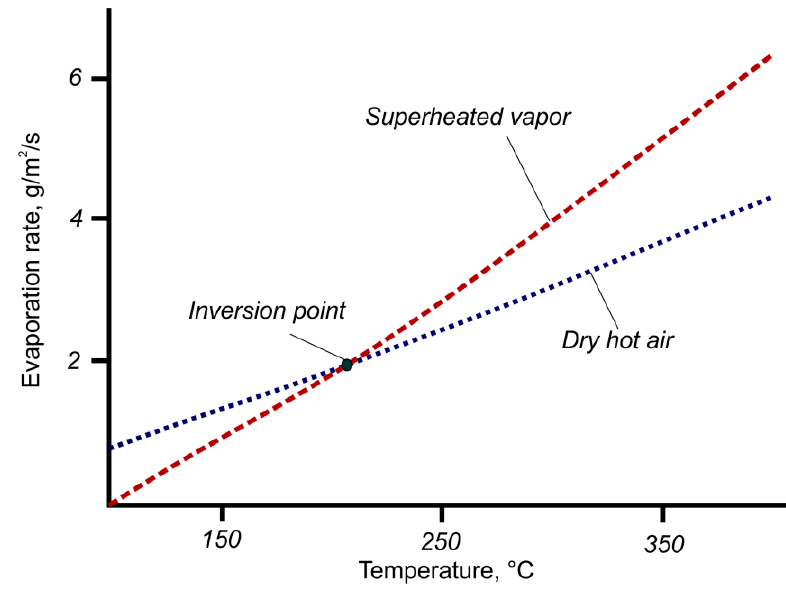
Figure 2. Inversion temperature (Based on [30]).